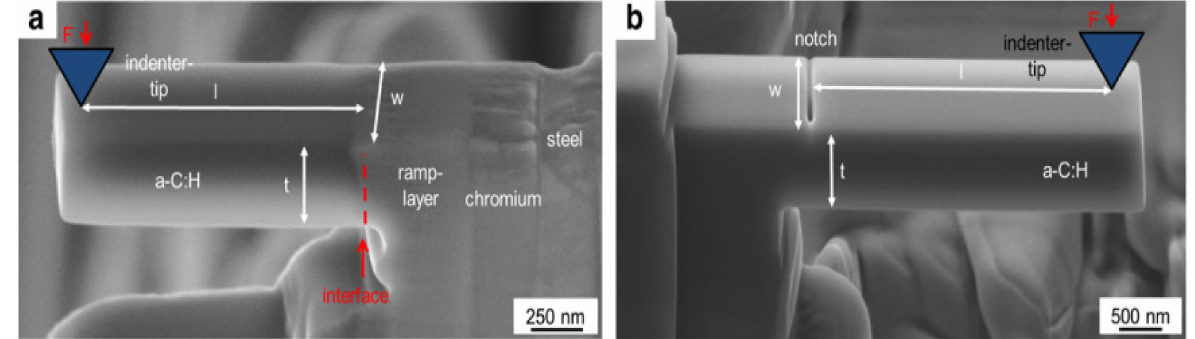
Figure 21. ( a ) Micro-cantilever beam fabricated by FIB for the measurement of the interfacial fracture strength. ( b ) Notched bulk a-C:H cantilever for the measurement of the fracture toughness of a-C:H [13].